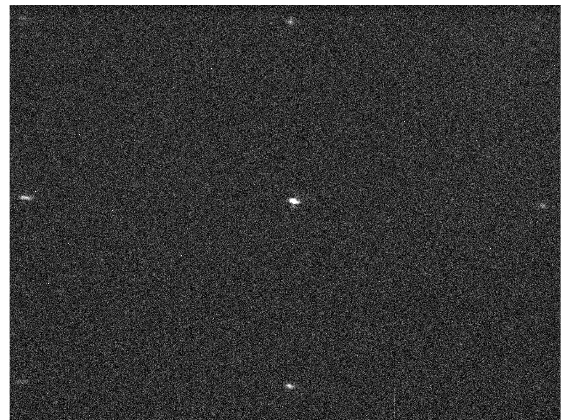
FIG. 5. Diffraction pattern from the mesh as observed by the far field